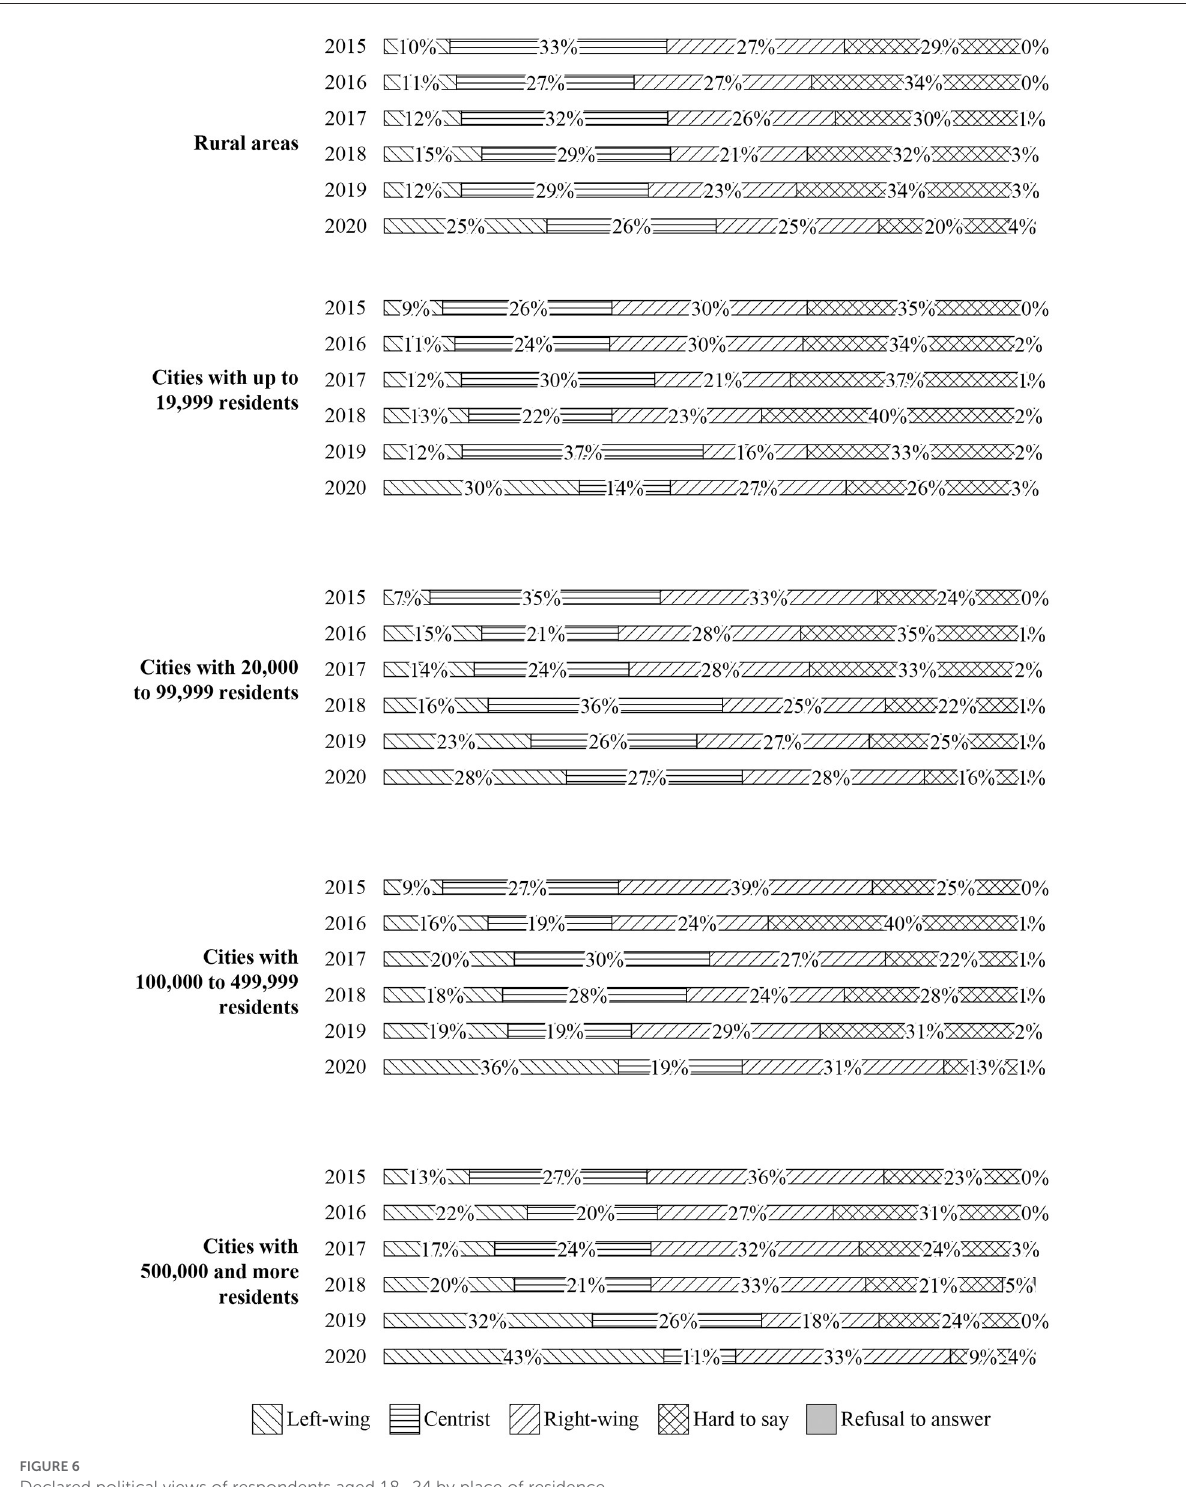
FIGURE6 Declared political views of respondents aged 18–24 by place of